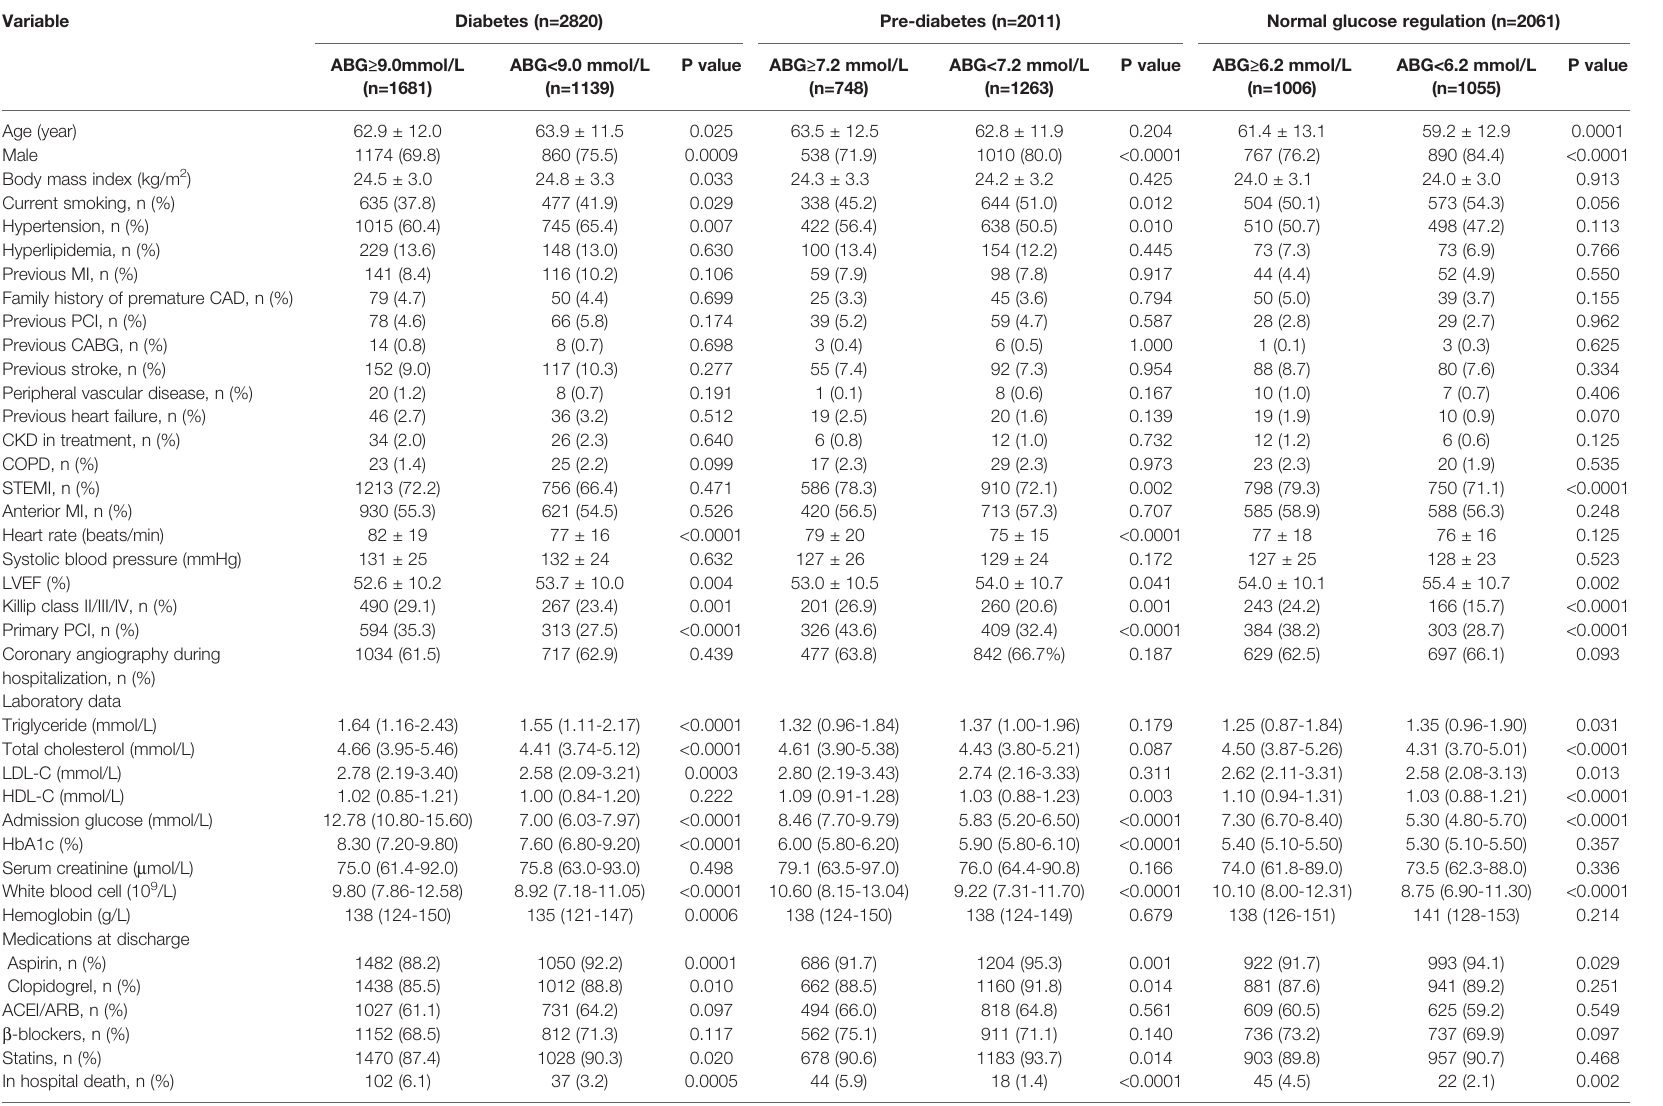
TABLE 1 | Baseline characteristics of the study population according to glucose metabolism status and admission blood glucose